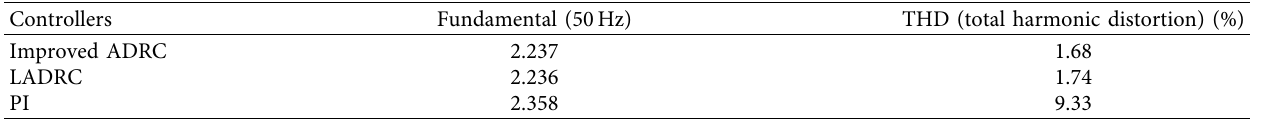
Table 4: Harmonic analysis comparison of phase A